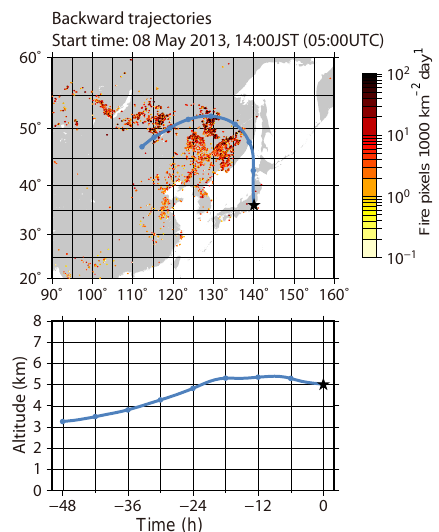
Figure 20. Two-day backward trajectory of air mass observed on 8 May 2013. The upper panel also shows fire activity from 1 to 9 May 2013 (color scale), based on data of MODIS active-fire products (NEO,